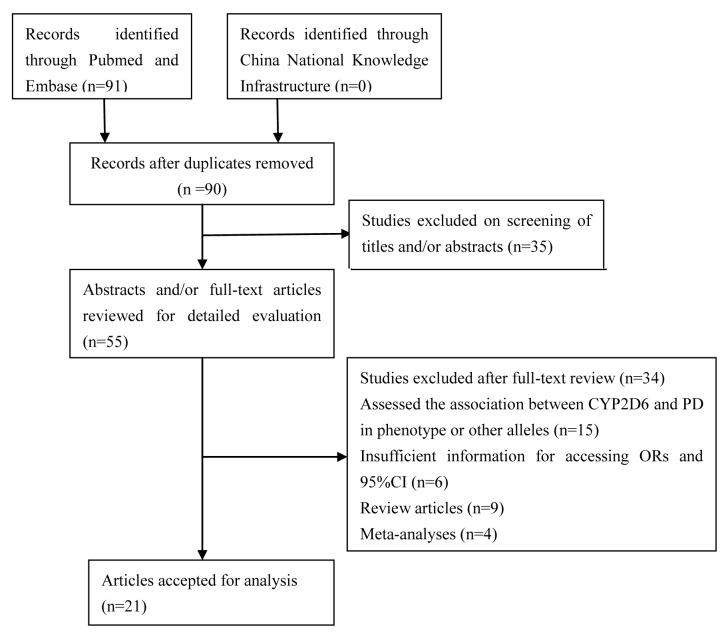
Flow diagram for the selection of articles for inclusion in the meta-analysis.